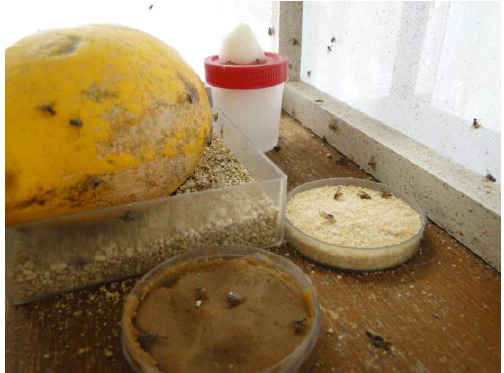
Figure 1. C. capitata in a rearing cage, water; artificial fruit; adult food; papaya.